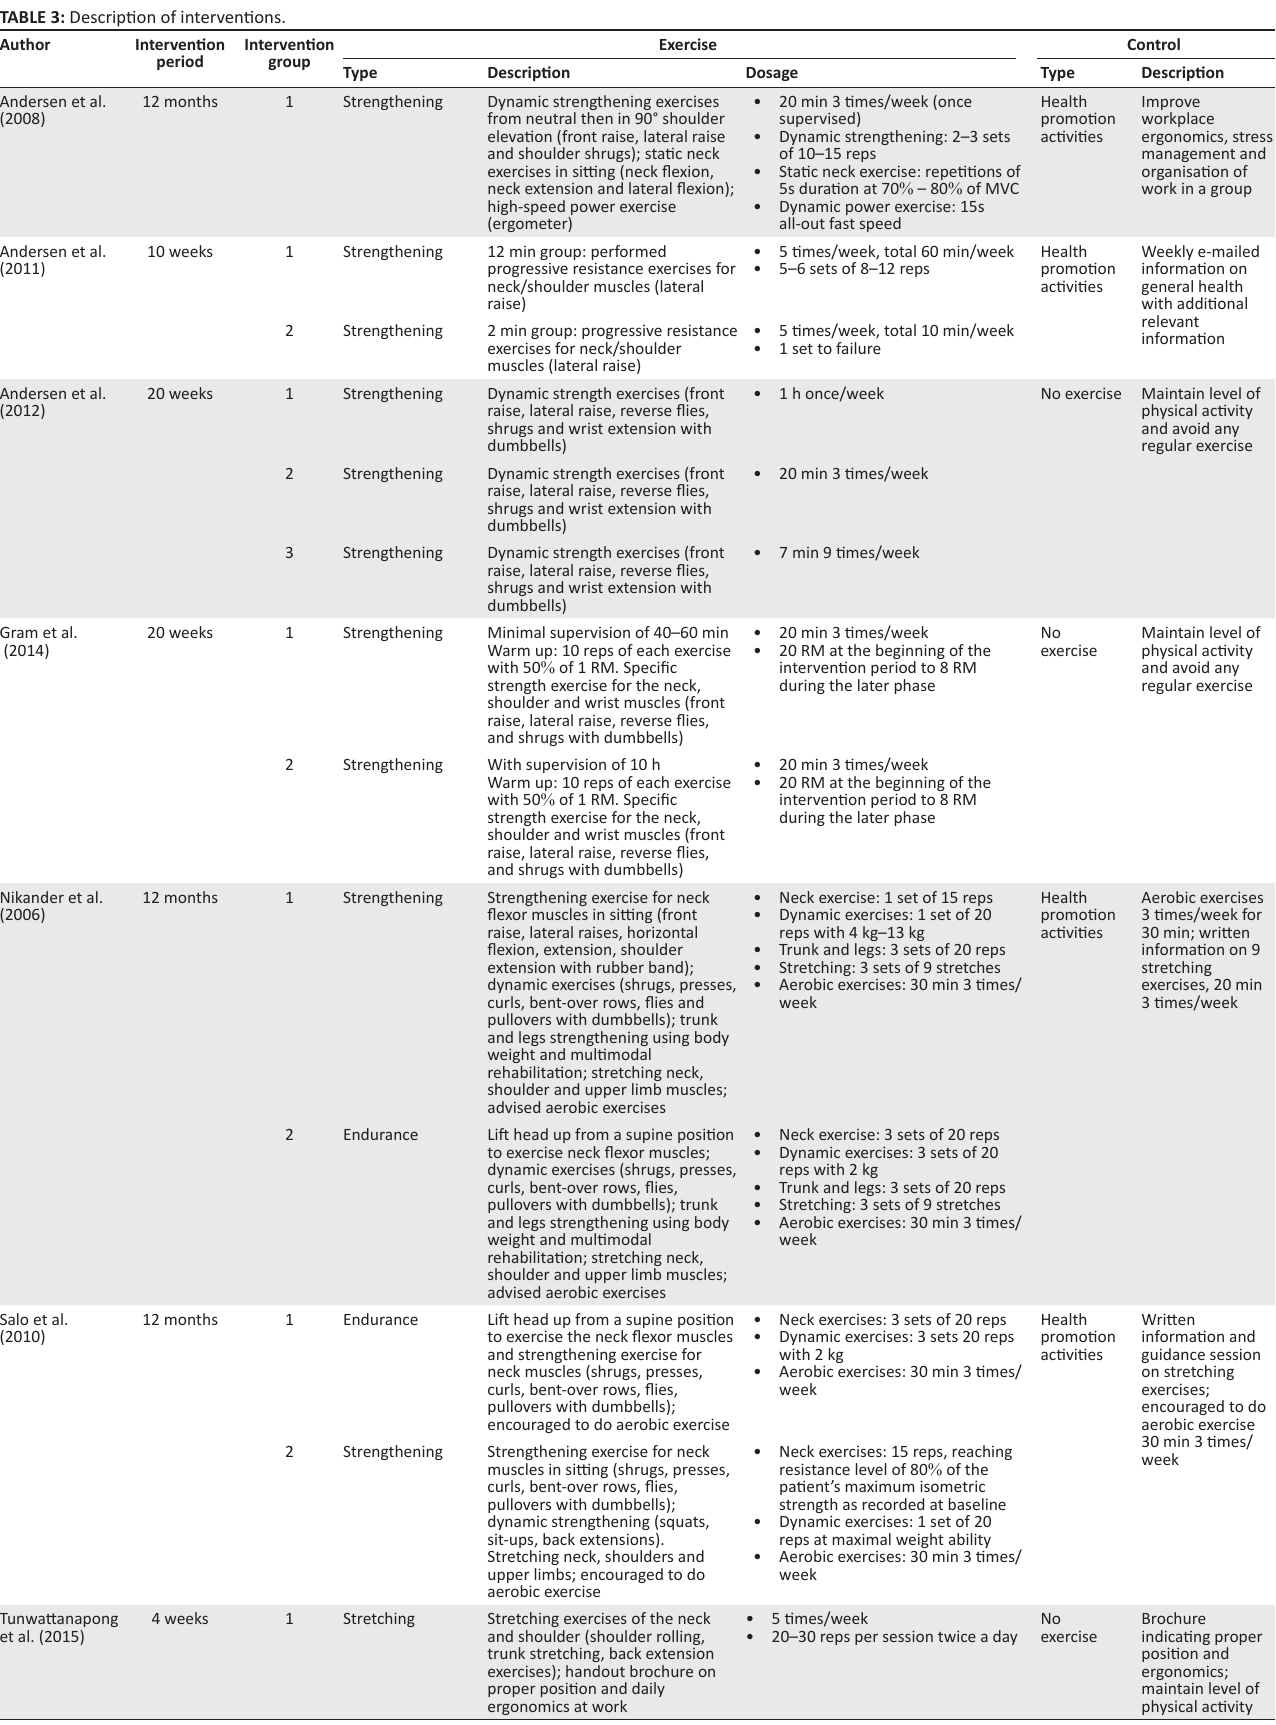
TABLE 3: Description of